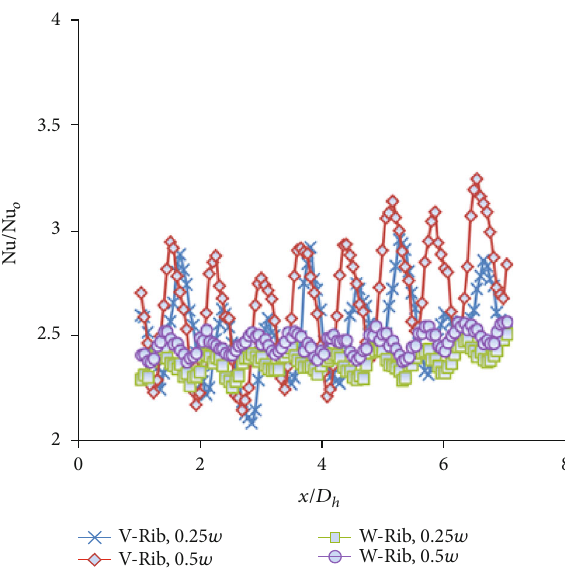
Figure 6: Streamwise variation of Nu/Nu